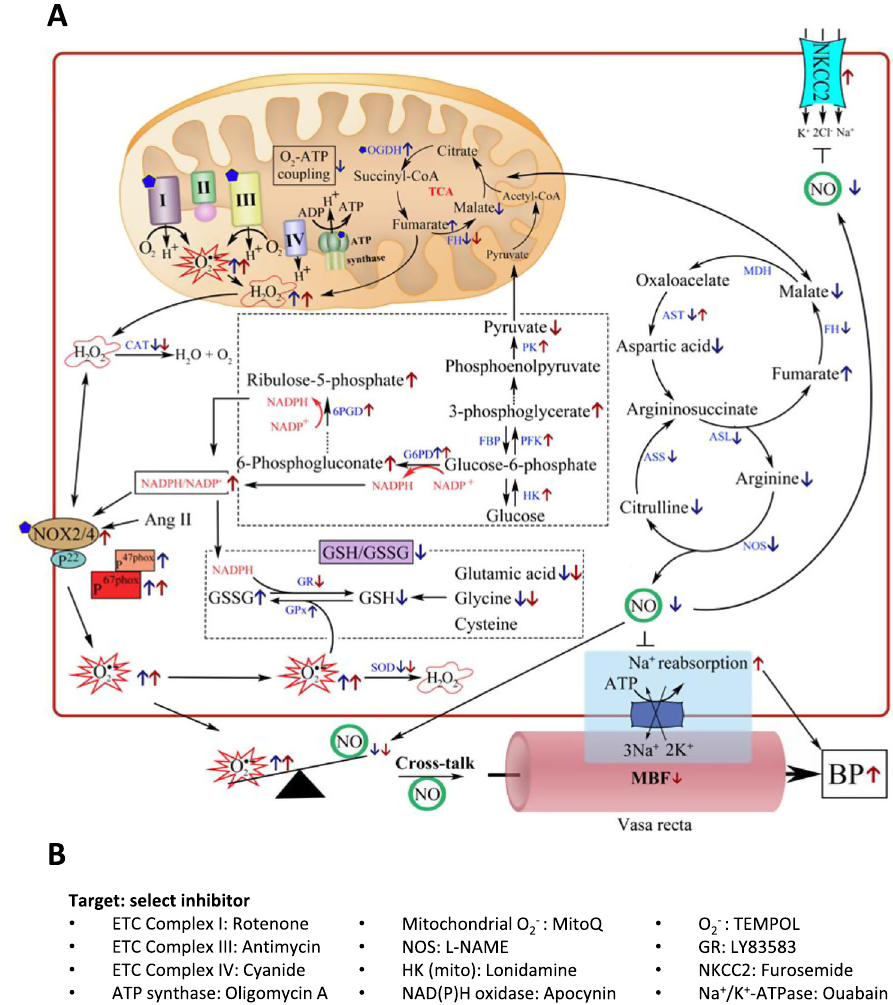
Fig. 2 Renal metabolic mechanisms of hypertension in Dahl salt-sensitive (SS) rats. A Renal metabolic mechanisms of hypertension. This fi gure is primarily based on data obtained from analyses of the renal medulla or the medullary thick ascending limb of the loop of Henle in SS rats. Some of the indicated changes also occur in the renal cortex. The blue arrows represent increased or decreased content (or activity) in SS rats relative to salt-insensitive rats, including SS-13 BN rats. The red arrows represent increased or decreased content (or activity) in SS rats fed a high-salt diet. Blue pentagons represent sites of reactive oxygen species generation. Black arrow and inverted T mark ( ⊥ ) represent positive and negative in fl uence, respectively. Some of these regulatory relations and their causal role in the development of hypertension remain to be tested in the speci fi c context of SS kidneys. TCA tricarboxylic acid cycle, OGDH α -ketoglutarate dehydrogenase, FH, fumarase; MDH, malic dehydrogenase; ASS, argininosuccinate synthetase; ASL, argininosuccinate lyase; AST, aspartate aminotransferase, NOS nitric oxide synthase, HK hexokinase, PFK phosphofructokinase, G6PD glucose-6-phosphate dehydrogenase, 6GPD 6-phosphogluconate dehydrogenase, GSH glutathione, GSSG glutathione disul fi de, GR glutathione reductase, GPx glutathione peroxidase, NKCC2 Na – K-2Cl cotransporter, SOD superoxide dismutase, CAT catalase, MBF medullary blood fl ow. B Examples of chemical inhibitors of components of the metabolic mechanisms shown in panel ( A ). Other inhibitors may be available, and the inhibitors listed may have additional targets. ETC electron transport chain, L-NAME L-N G -nitro arginine methyl